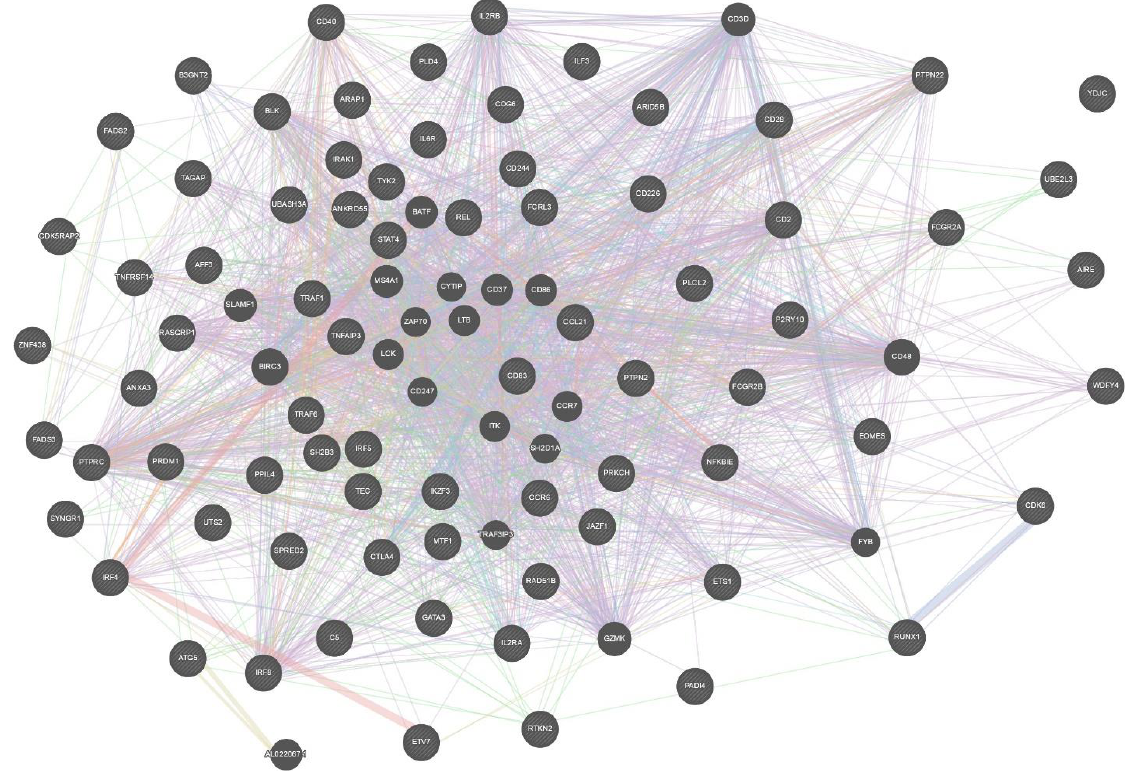
Figure 5. Gene–gene interaction network generated by GeneMANIA for all the interaction types. This figure was down- loaded as a high-quality image file from GeneMANIA v3.5.1 (https://genemania.org/, accessed on 25 February 2021).